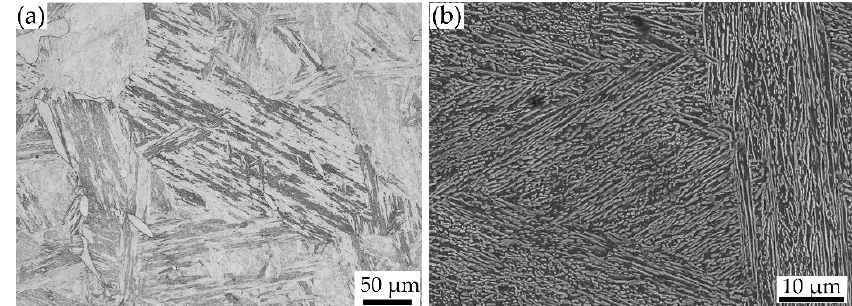
Figure 3. Microstructure of original casting. ( a ) OM, ( b ) SEM.